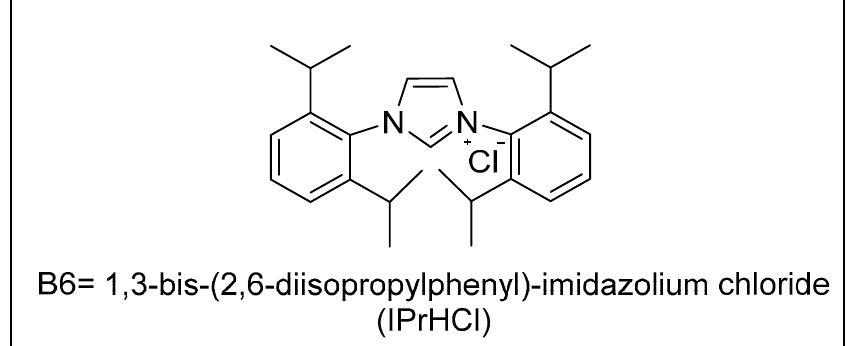
Figure 13. Imidazolium-based NHC ligands precursor.